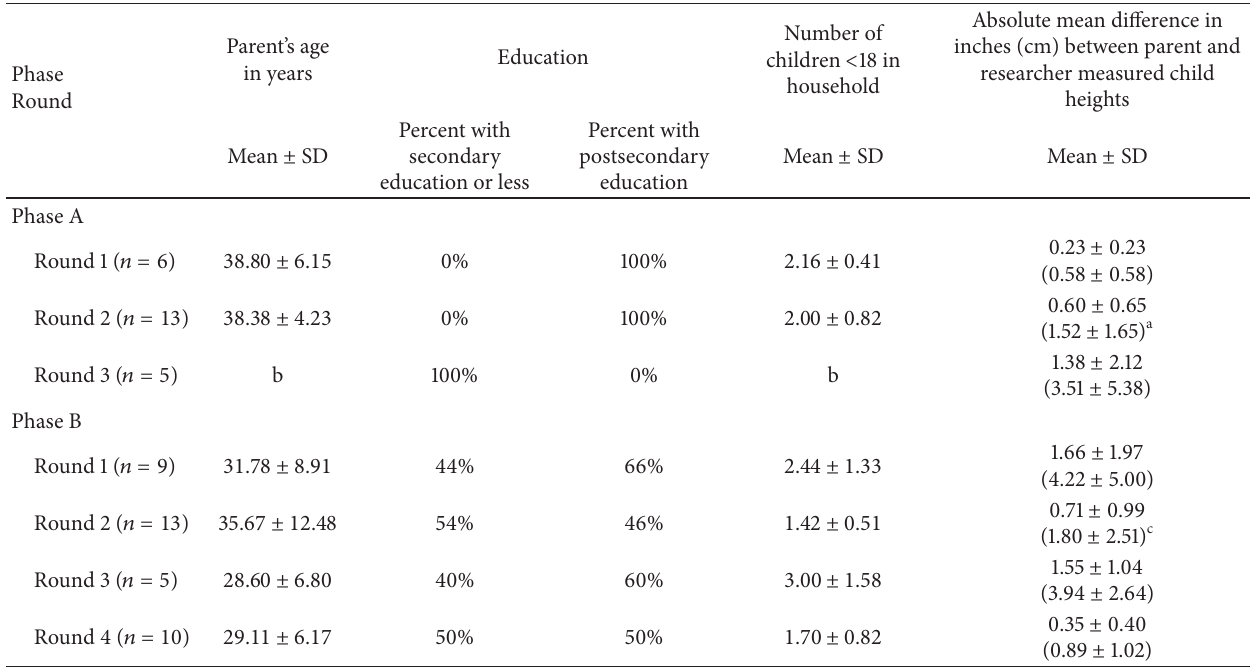
Table 1: Characteristics of participants and accuracy of child height measurements.